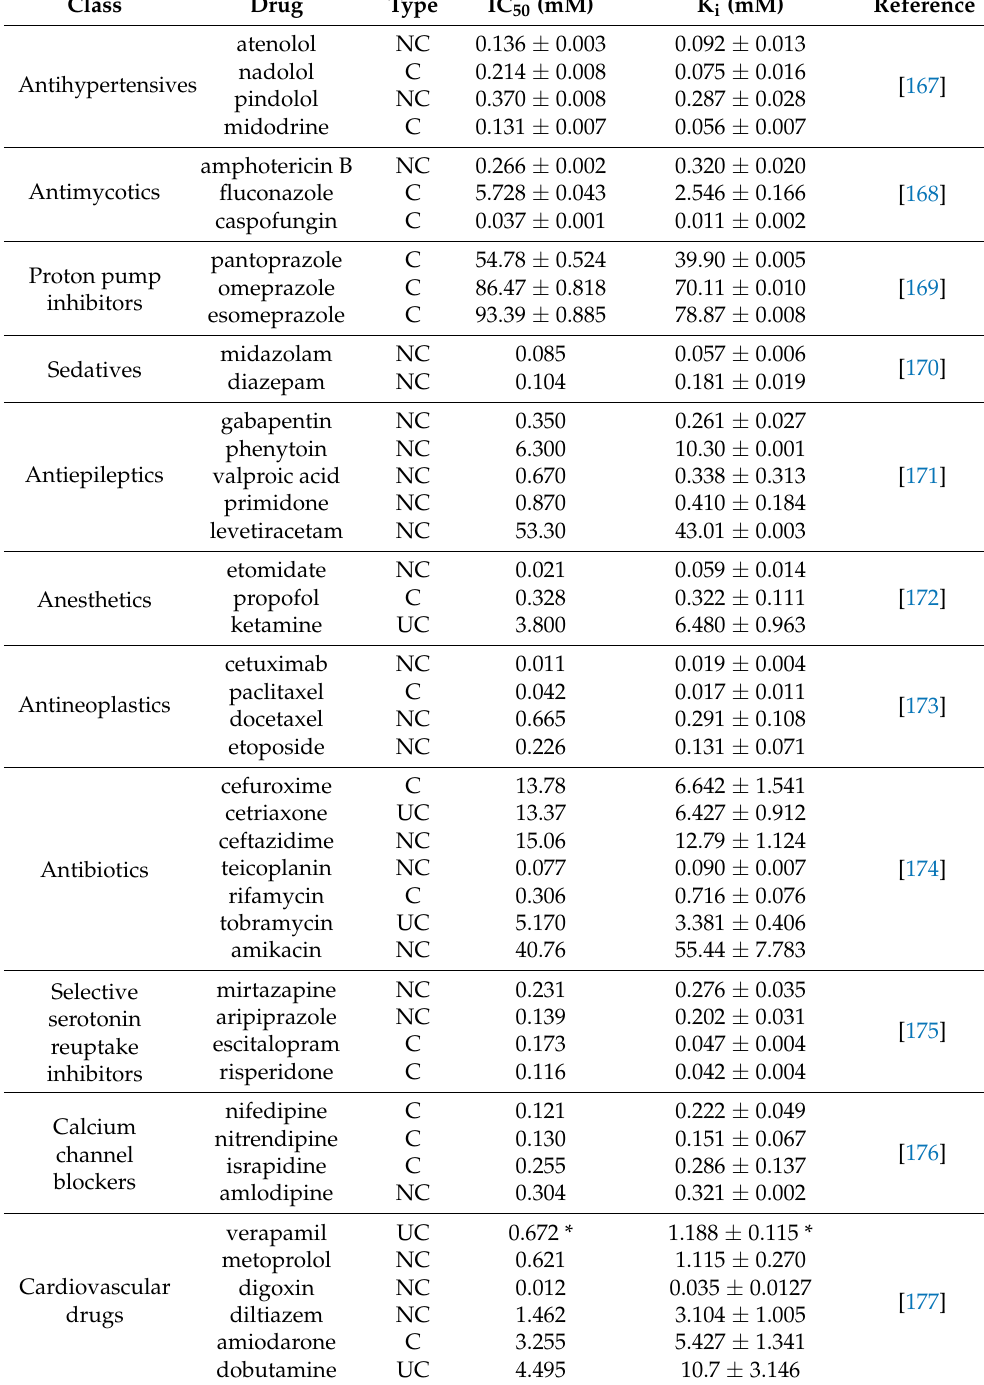
Table 1. List of PON1-inhibiting drugs grouped according to their application. The half maximal inhibitory concentration (IC 50 ) and inhibition constant (K i ) values have been calculated by authors based on paraoxonase activity measurement. Types of inhibition include competitive (C), uncompeti- tive (UC) or noncompetitive